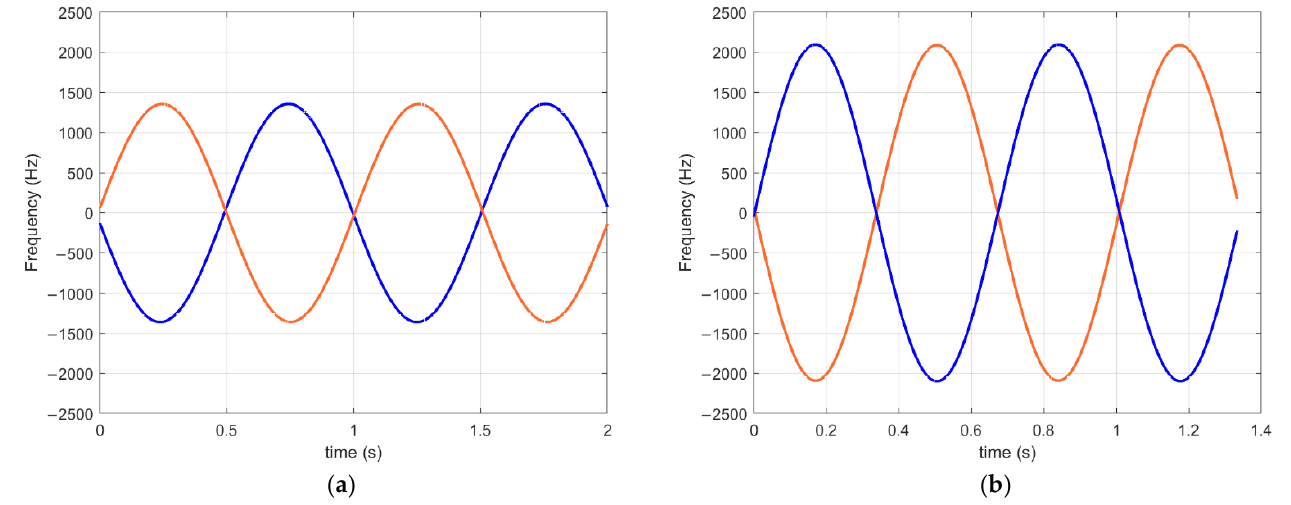
Figure 16. Blade tip discrete time – frequency curves: ( a ) Blade tip discrete time – frequency curve of P1. ( b ) Blade tip discrete time – frequency curve of P2.